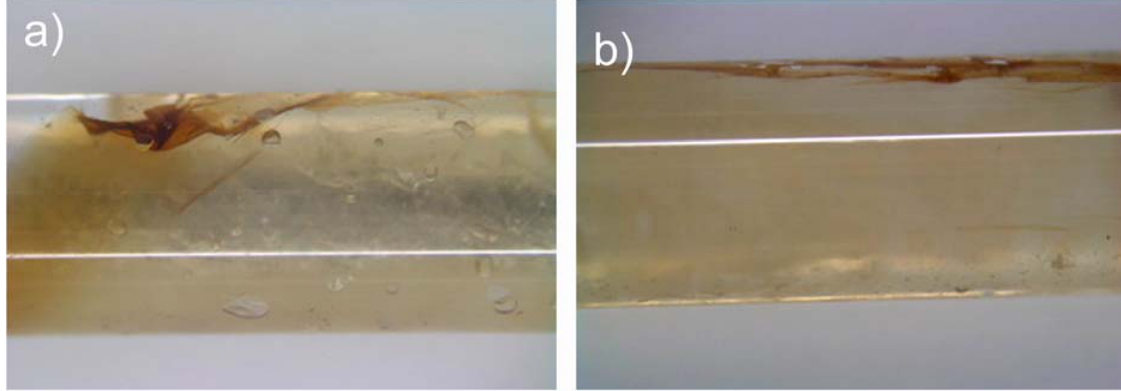
Figure 7 . Photographs of the hybrid actuator assembled from films and swollen Cabloc CT hydrogels in a 2 mm diameter glass tube. There are two common defects: (a) the film adheres well to the inner surface but some parts of the film overlap. (b) At lower loading of hydrogel, there are bubbles between the wall and the film. Both structures will result in wrong reconstructions of the inner surface. White lines on the tubes are reflection on the glass from the lamp used to illuminate the